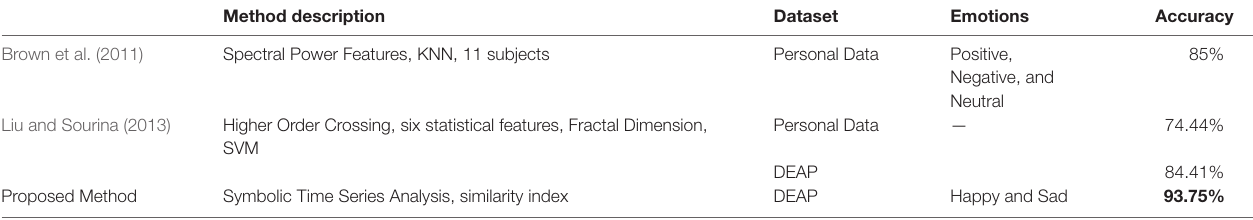
TABLE 2 | Comparison of different studies for emotion recognition using EEG—three groups of emotions.